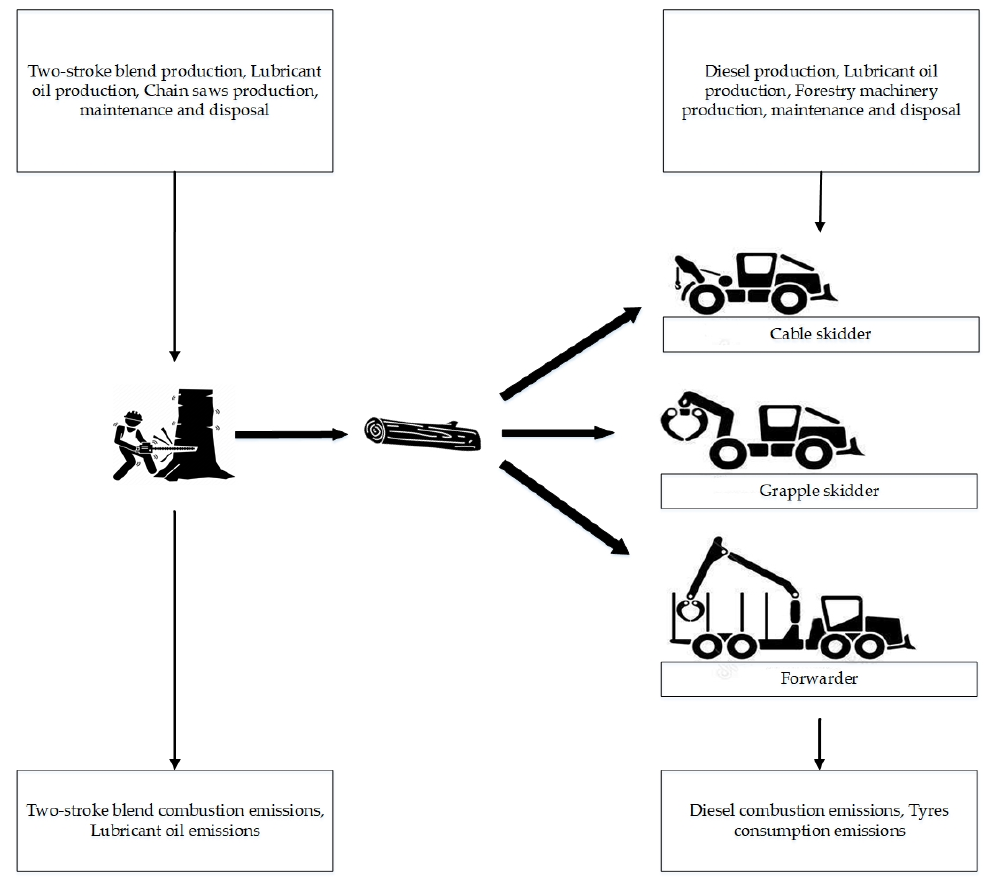
Figure 2. System boundary flow chart.